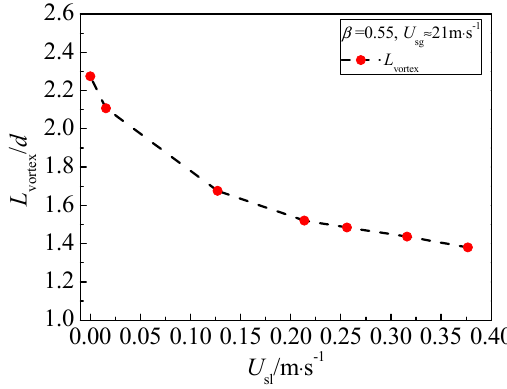
Figure 12. Relationship between vortex length and liquid velocity.